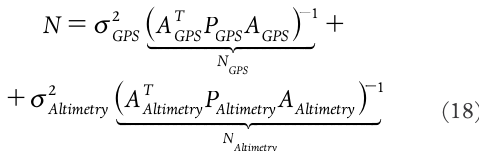
Figure 2: Distribution of Jason-2 observation and GPS reference stations for August 25, 2012.